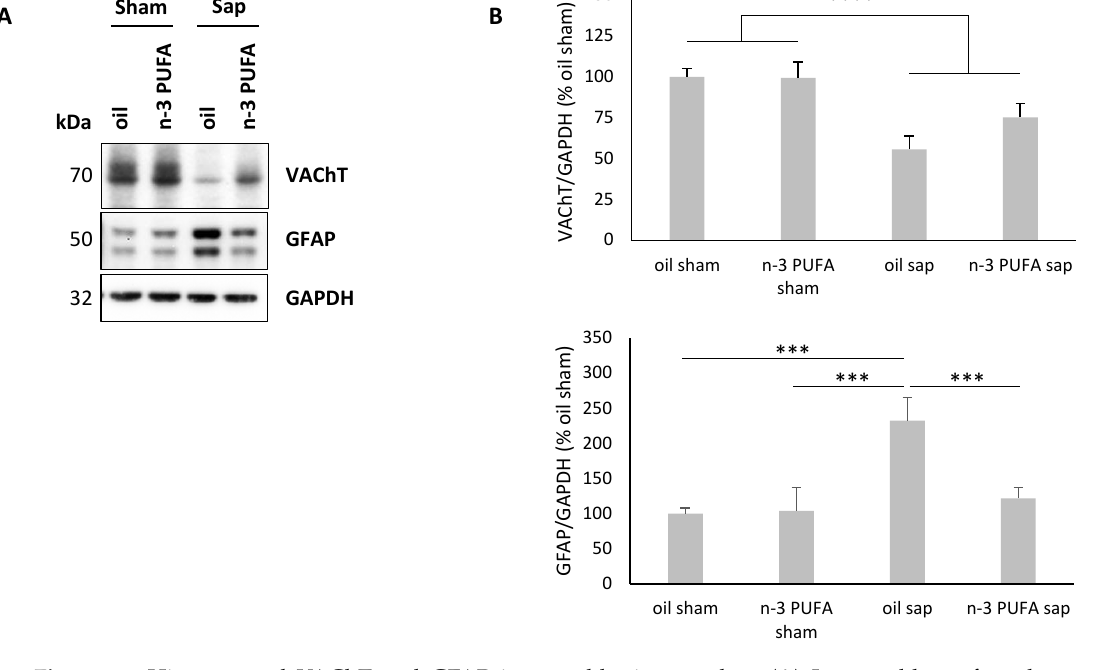
Figure 7. Hippocampal VAChT and GFAP immunoblotting results. ( A ) Immunoblots of total hippocampal proteins from 24-month-old mice. ( B ) The histogram shows densitometric quantification of changes in gray values, expressed as % of oil sham group. Data of the four experimental groups are depicted as mean and SEM. GAPDH was used as loading control. (VAChT analysis: oil sham, n = 11; n-3 PUFA sham, n = 10; oil sap, n = 8; n-3 PUFA sap, n = 7; GFAP analysis: oil sham, n = 11; n-3 PUFA sham, n = 9; oil sap, n = 9; n-3 PUFA sap, n = 7). Statistical significance of the post-hoc